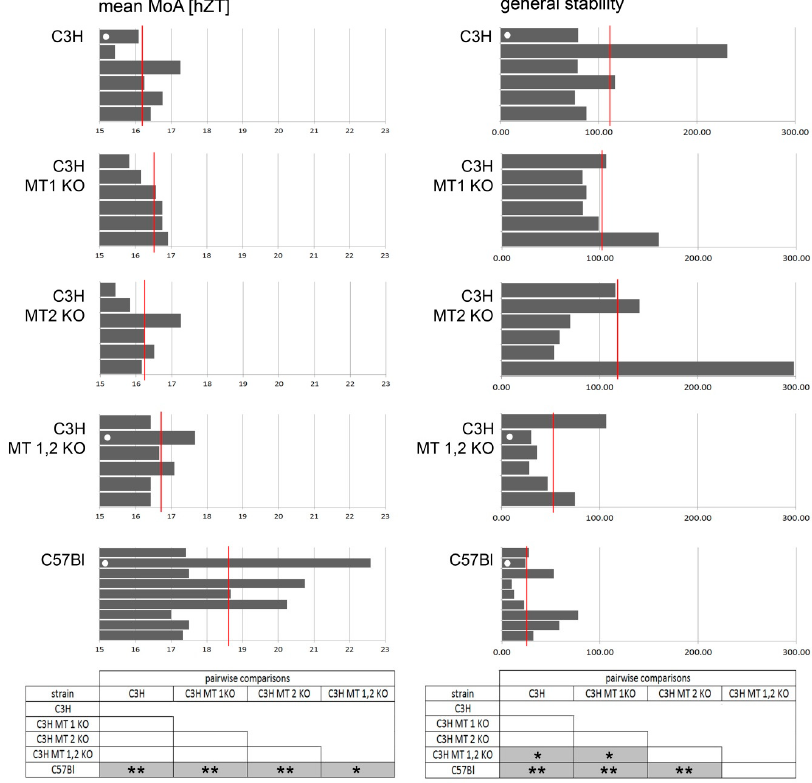
Figure 1. Chronotype (mean MoA) and general stability in interstrain comparisons. Each bar in the histograms represents a single mouse; the red lines indicate the mean values. The white dots in the bars indicate individual mice whose actograms are shown in Figure 2. The pairwise interstrain comparisons shown in boxes below are Bonferroni–Holm corrected Conover–Iman comparisons that were carried out on the sets of data stemming from the individual strains; shaded boxes with asterisks (* p < 0.05; ** p < 0.01) indicate significant differences between the respective strains. Prior to these pairwise tests, Kruskal–Wallace tests were applied and they confirmed ( p < 0.01) the inhomogeneity of the strains with respect to the measurement parameters.